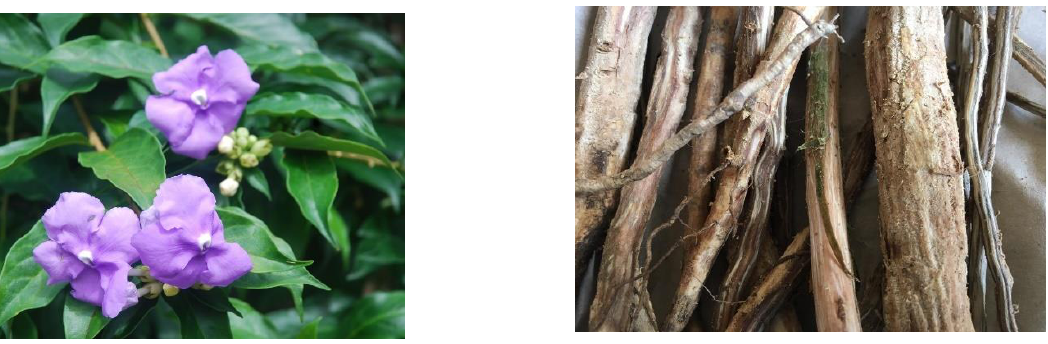
Figure 1. Brunfelsia grandiflora from Perú. On the right is the plant in the flowering period (photo courtesy of Jana Horackova), and on the left is the bark used to obtain the extract used in the present study.